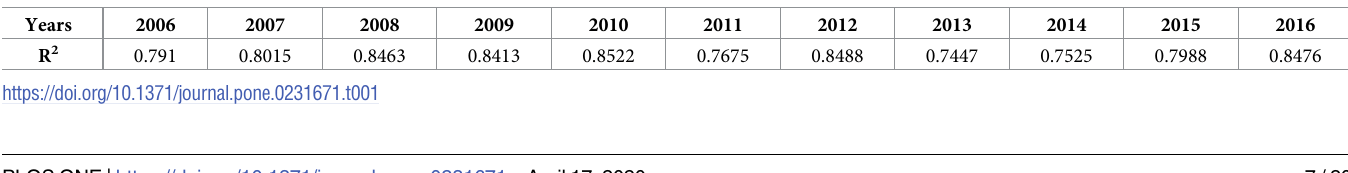
Table 1. Goodness of fit between the observed and simulated